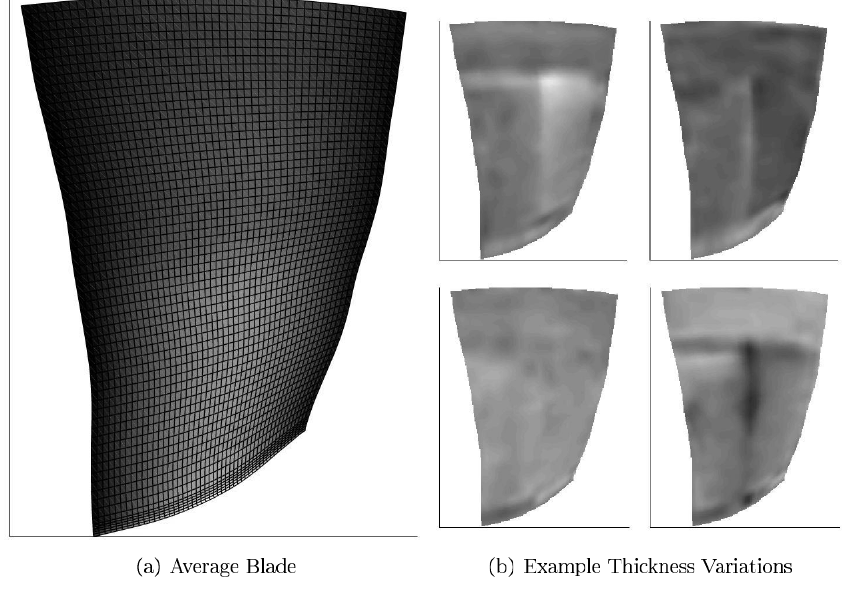
Fig. 2. Blade dimension